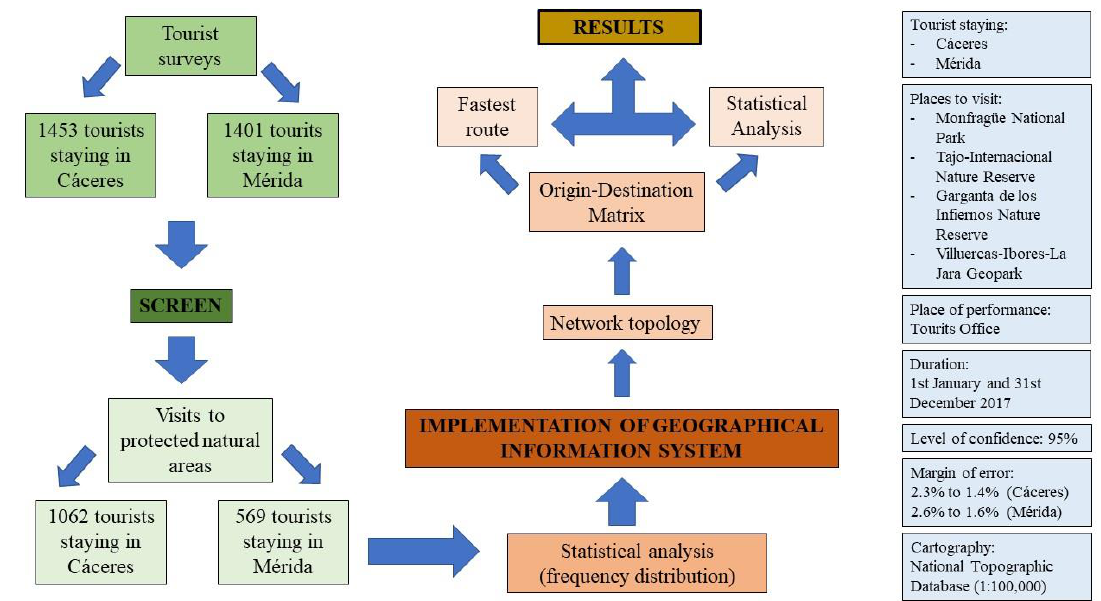
Figure 2. Methodological design.